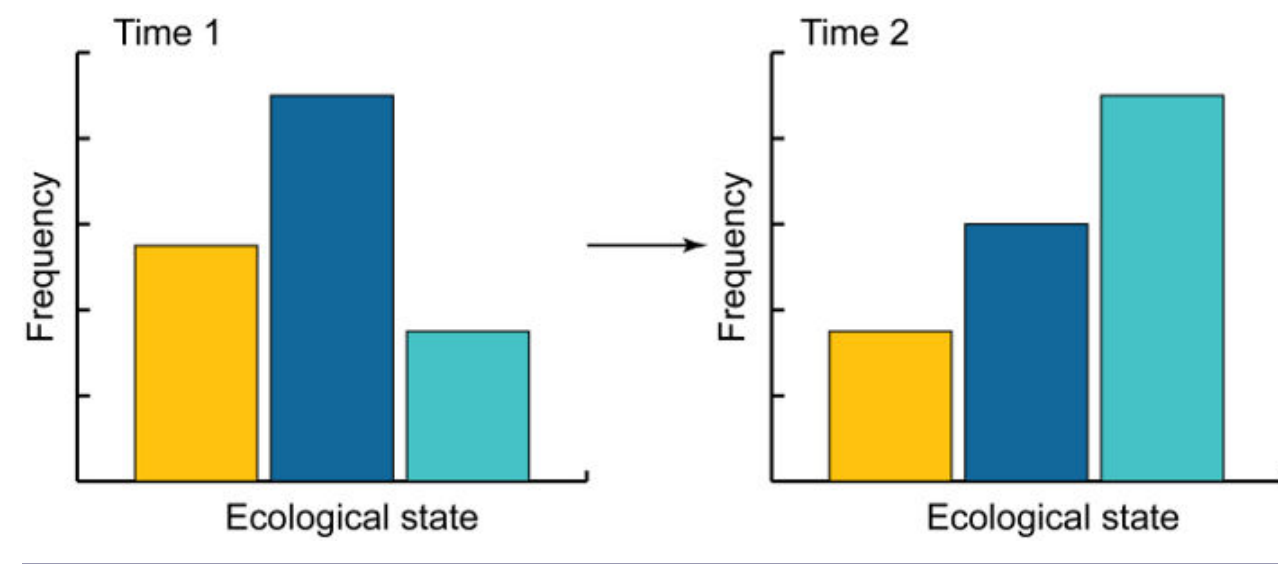
Fig. 2. Schematic illustration of the possible historical mixes of habitat quality in 7th-field watersheds of the Oregon Coast Range over time, with quality largely a function of the time since last major disturbance and the legacy of that